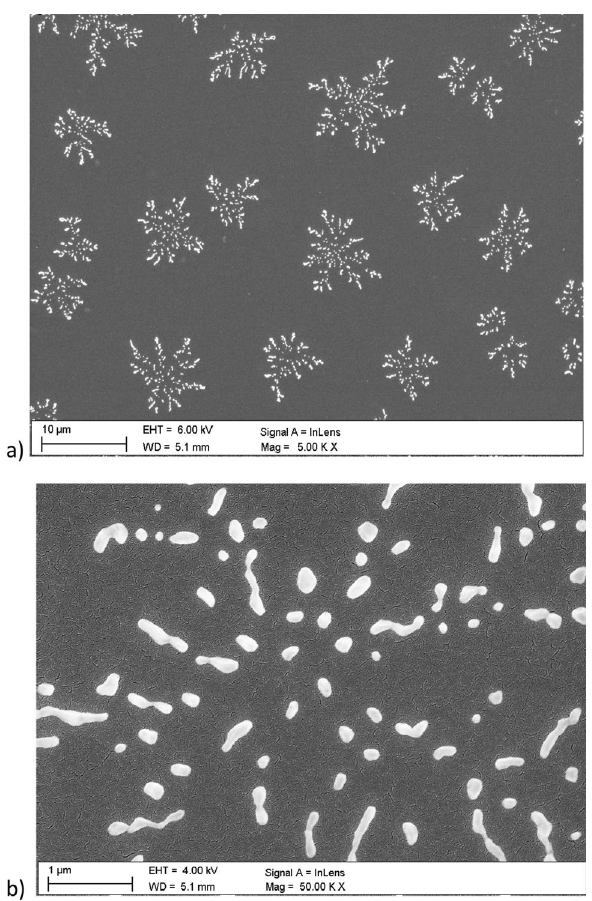
Figure 11. The Nb 2 O 5 “snowflakes” in surface of PMMA/ Nb 2 O 5 composite film with 2.5% nanoparticles content ( a ). The single “snowflake” ( b